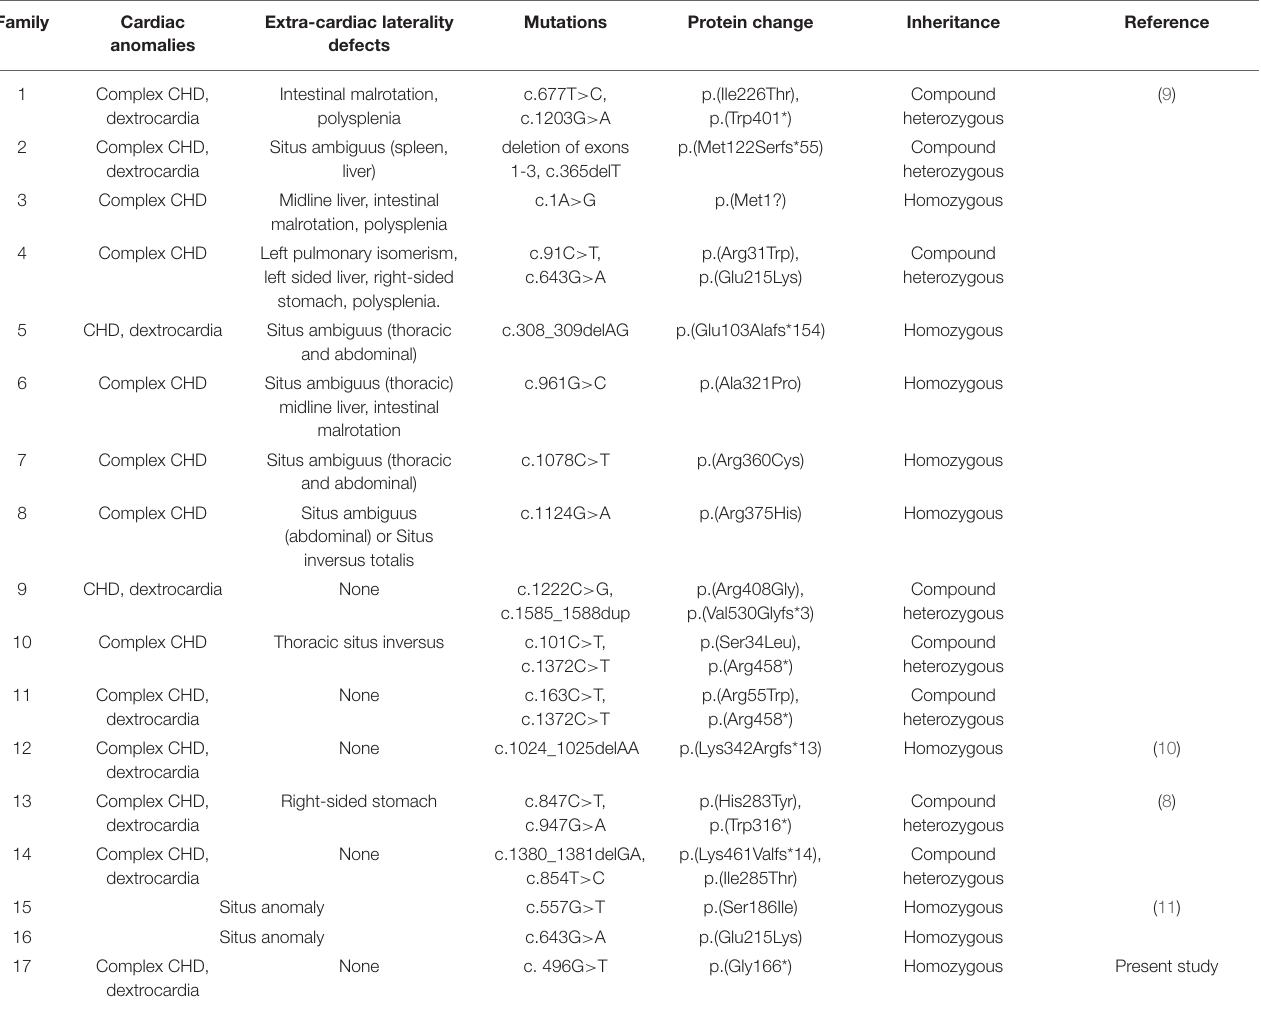
TABLE 2 | The summary of variants in MMP21